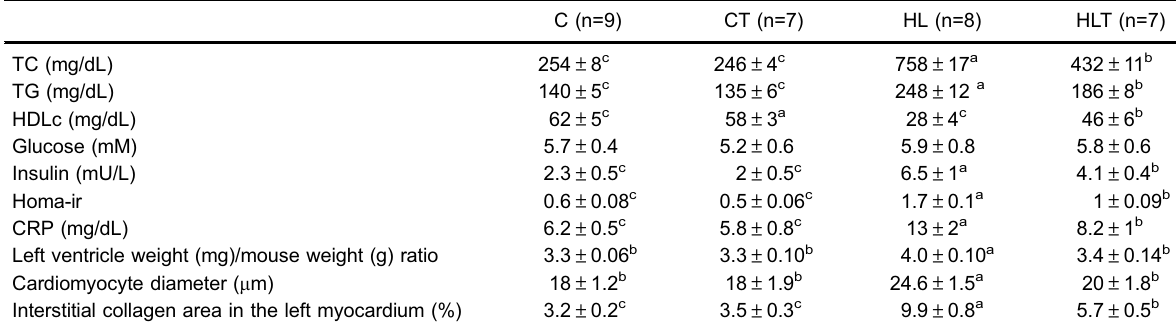
Table 1. Serum levels of total cholesterol (TC), triglycerides (TG), high-density lipoprotein cholesterol (HDLc), glucose, insulin, C reactive protein (CRP), and left ventricle weight (mg)/mouse weight (g) ratio, cardiomyocyte diameter, and interstitial collagen area in the left myocardium of LDLr-/- mice fed a standard diet (C), standard diet with tri-tea (CT), high-fat diet (HL), or high-fat diet with tri-tea (HLT).